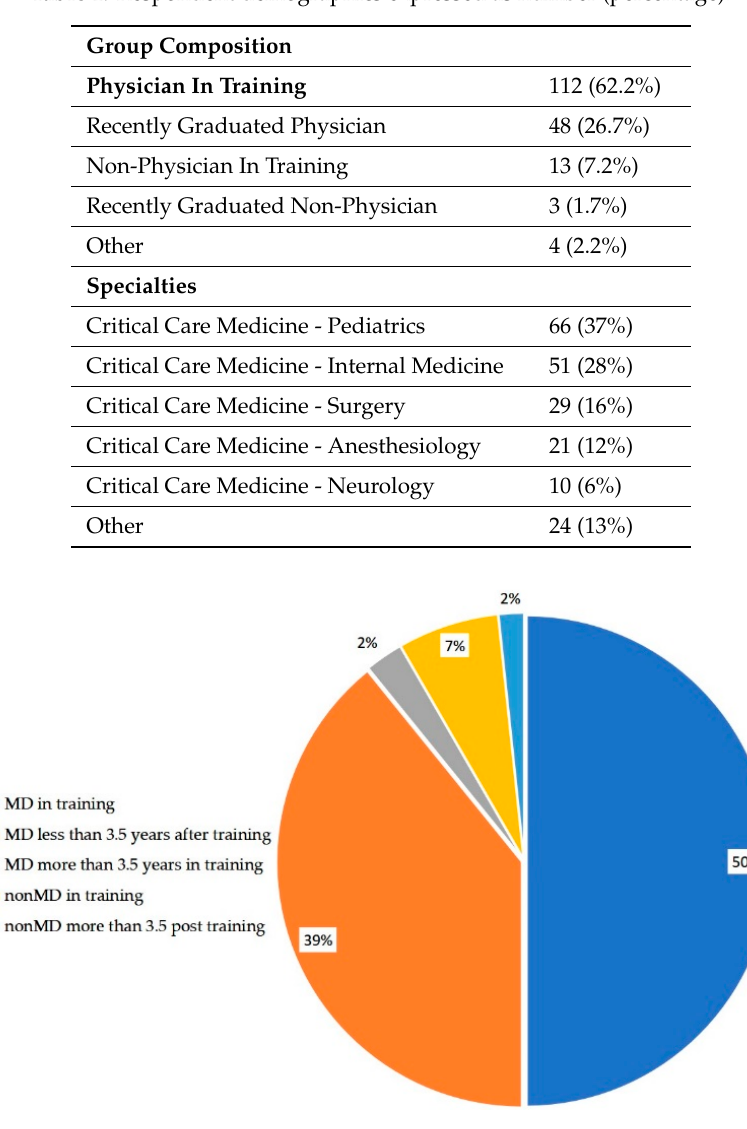
Figure 1. Demographics of people who were currently interviewing or have interviewed during the past 4 years.